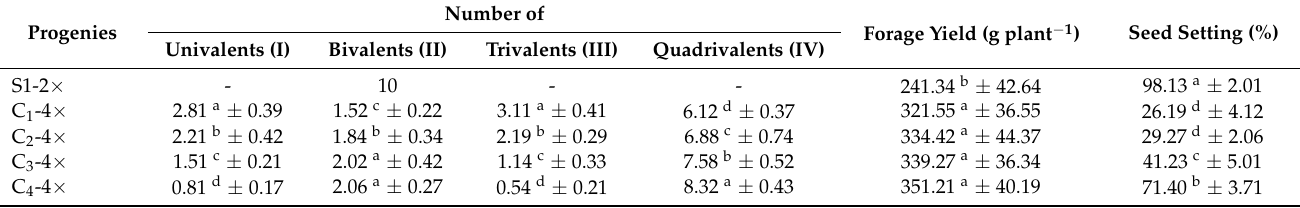
Table 3. Chromosome pairing of tetraploid (4 × ) offspring of maize selected for quadrivalent behavior [38]. Number of Progenies Forage Yield (g plant − 1 ) Seed Setting (%) Univalents (I) Bivalents (II) Trivalents (III) Quadrivalents